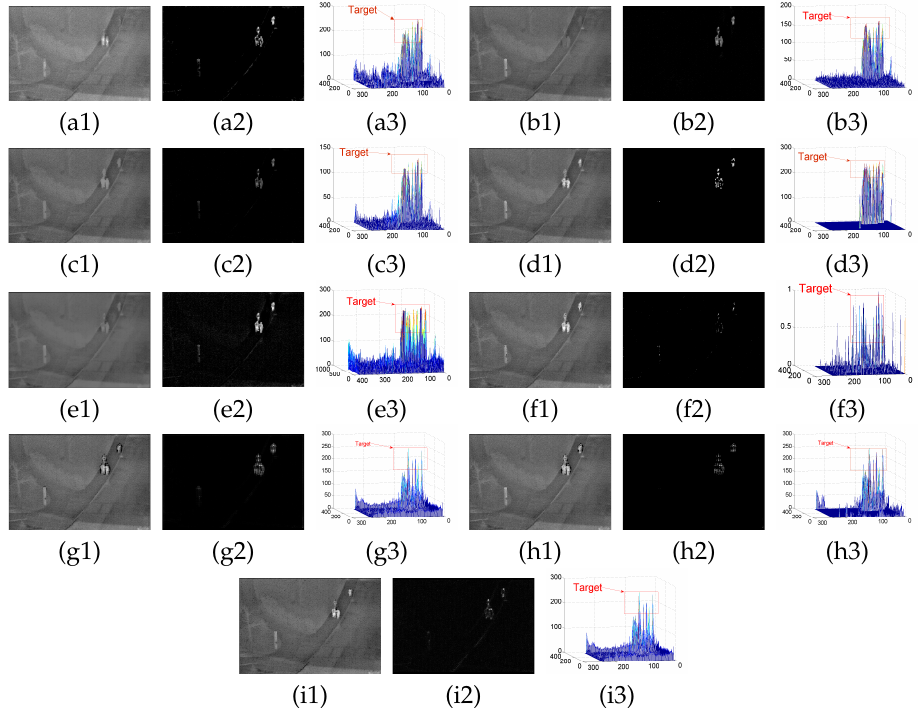
Figure 5. ( a – i ) denote the detection results of the PSTNN, RPCA, TV-PCP, VNTFR, ASTTV, SRWS, C2, C3, and the proposed algorithm on sequence A, respectively, where ( a1 – a3 ) denote the background map, the differential map, and the 3D map of the obtained differential map, respectively. Table 2. Background modeling evaluation metrics for different